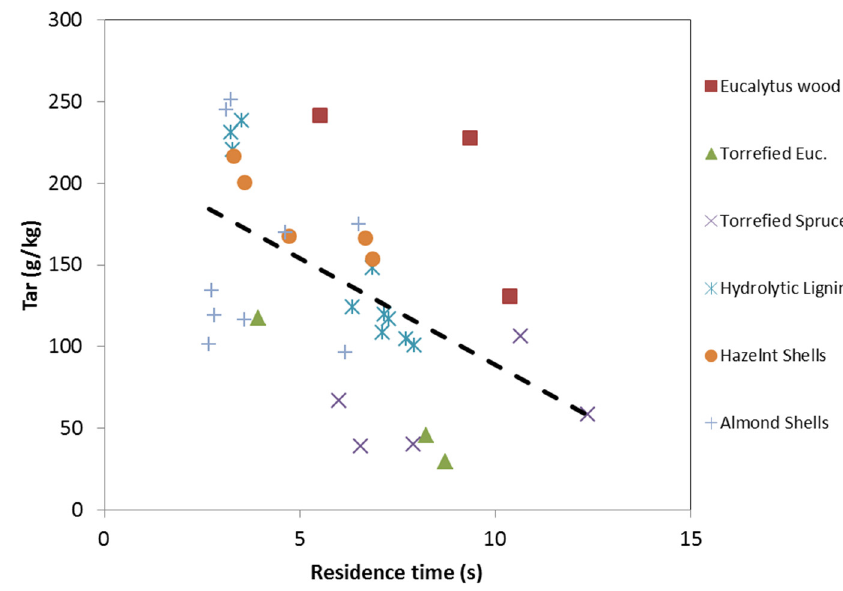
Figure 4. Yield of tar as function of residence time of the syngas in the bed.